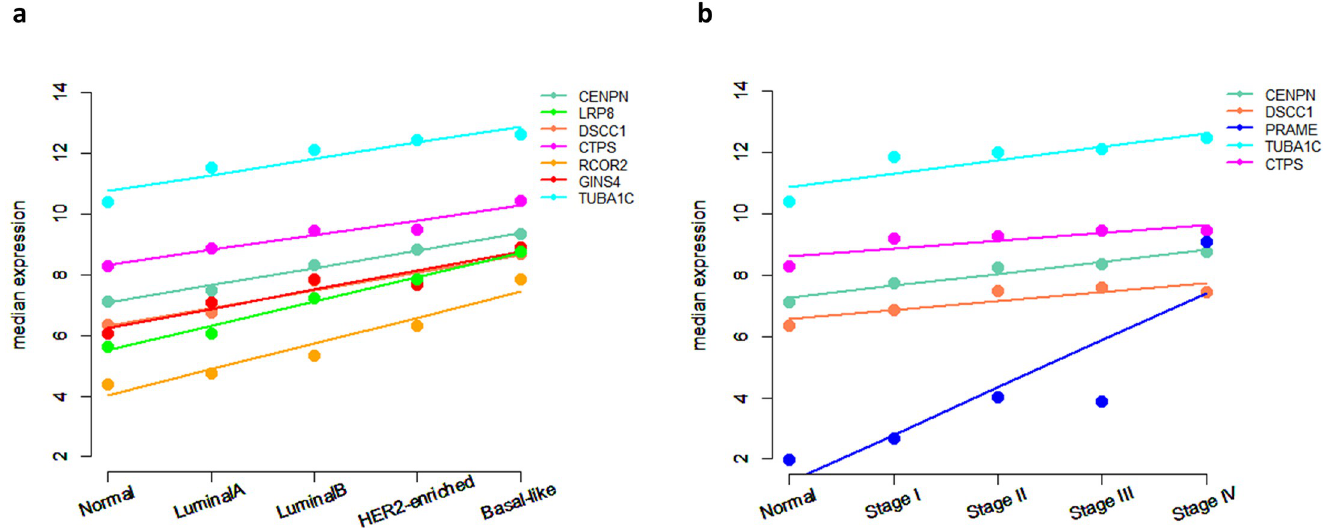
Fig 4. Linear regression model fitting. The median expression of the basal-like prognostic biomarkers is plotted against the phenotype varying from physiological to pathological condition (a) and against the pathological staging (b). Solid lines represent how the linear model fits the data. We showed, as a representative example, the results corresponding to the highest values of the model fitting index R-squared: R-squared (rounded to one decimal place) � 0.9 for the subtype (a) and � 0.7 for the staging (b).